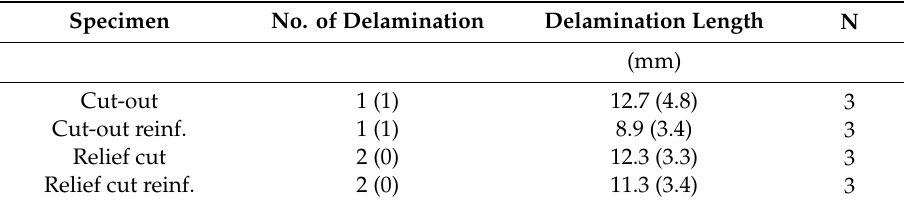
Table 2. Number and length of delamination after bending (SD in brackets).